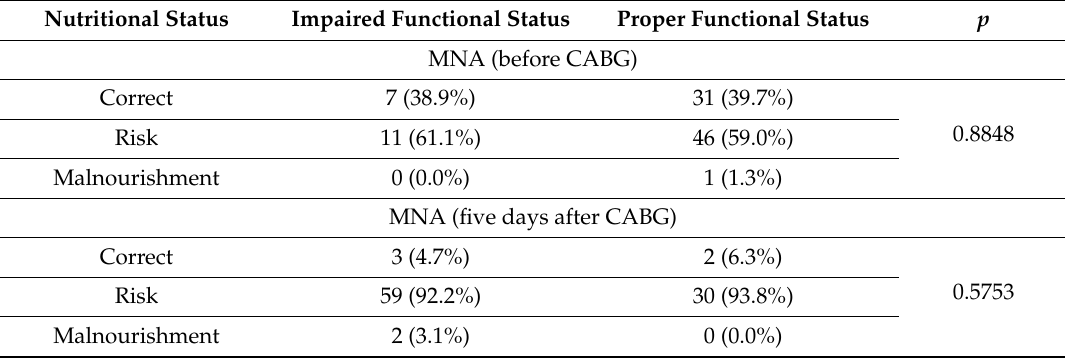
Table 10. Relationship between nutritional status (MNA) and the level of patients’ self-functioning before